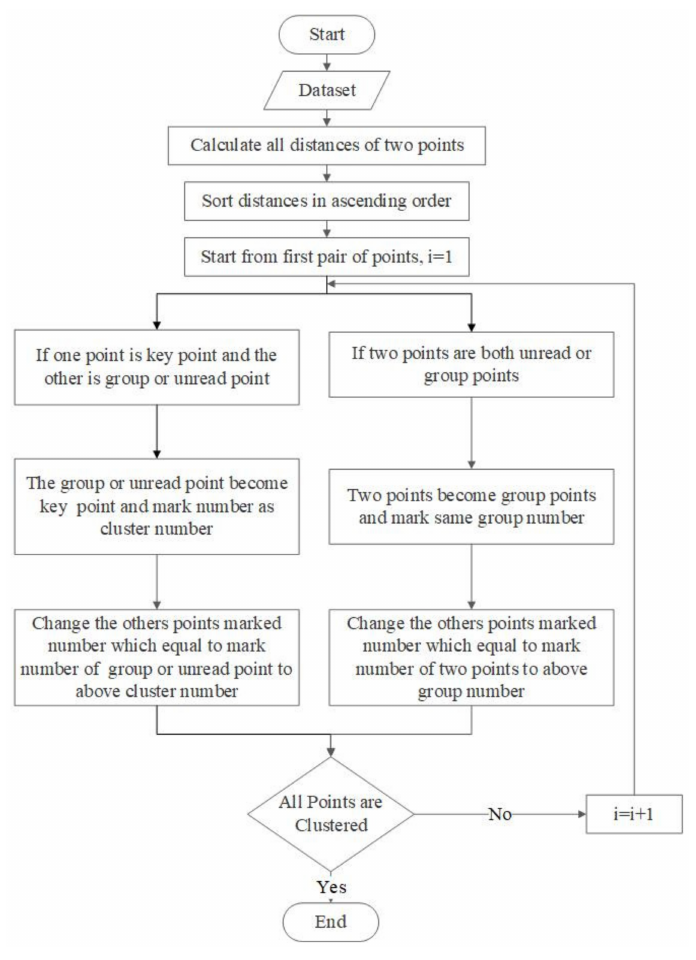
Figure 5. Logical flow of detect preliminary